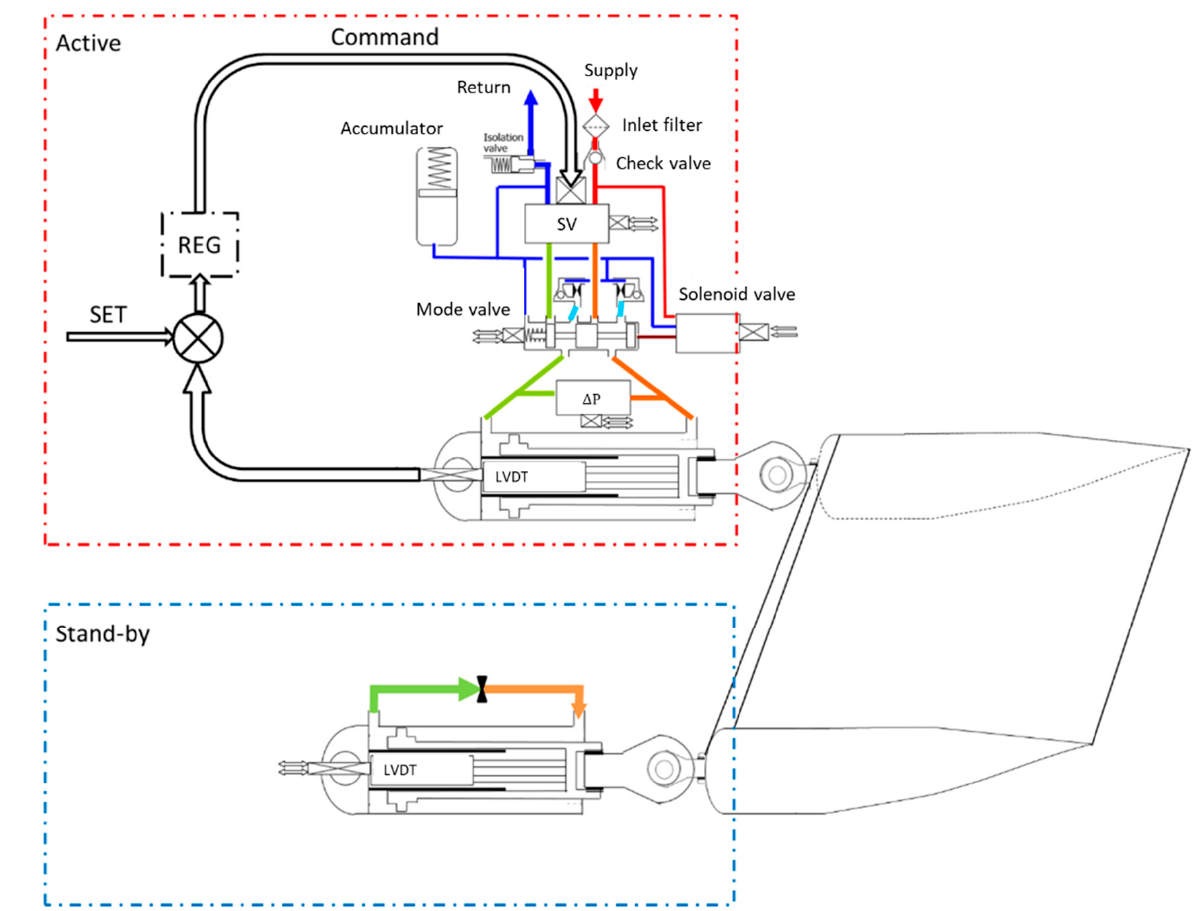
Figure 1. Architecture of the considered case-study.